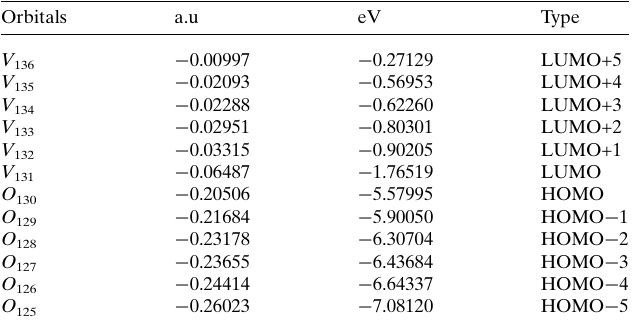
Table 3 The frontier molecular orbital energies of title compound.